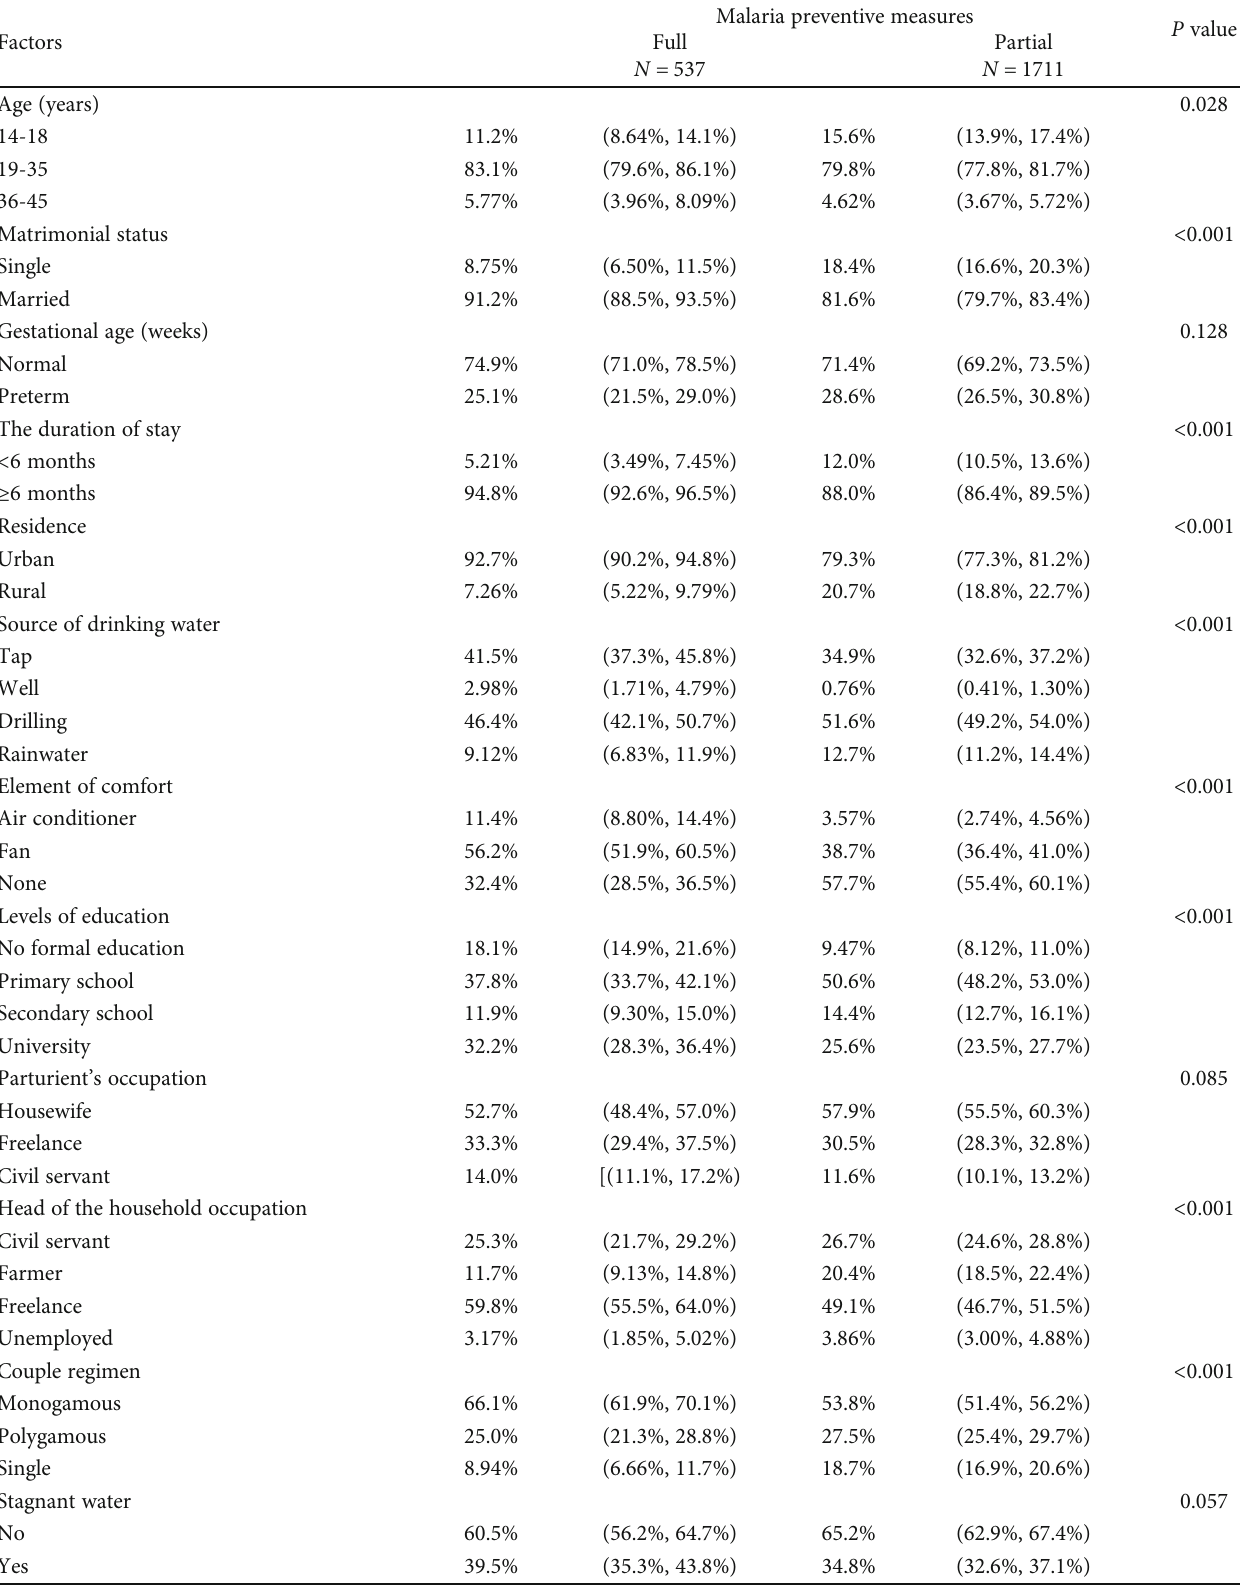
Table 2: Association of preventive measures and sociodemographic and obstetrical